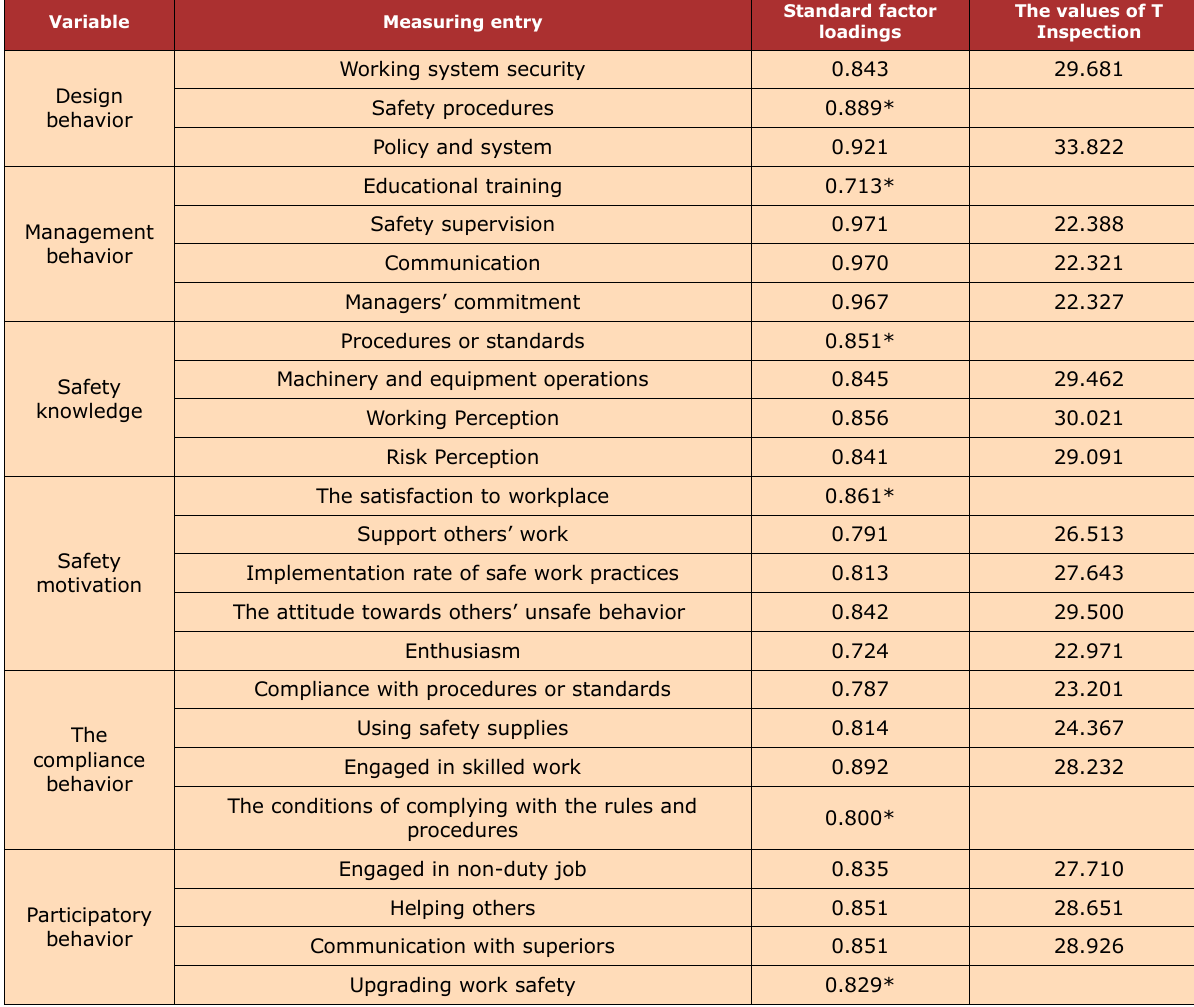
Table 4. Results of Confirmatory Factor